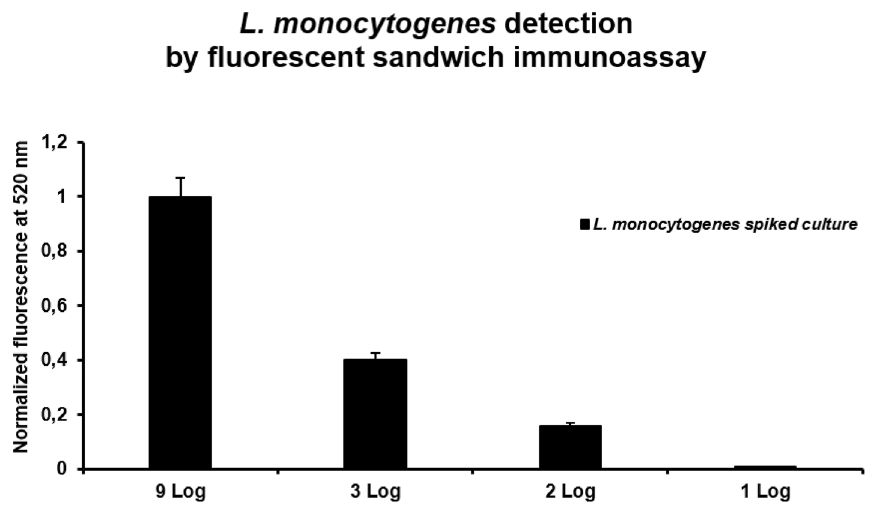
Figure 5. Sandwich fluorescence immunoassay: spike test. Sandwich fluorescence immunoassay of LM spiked samples (8 h of